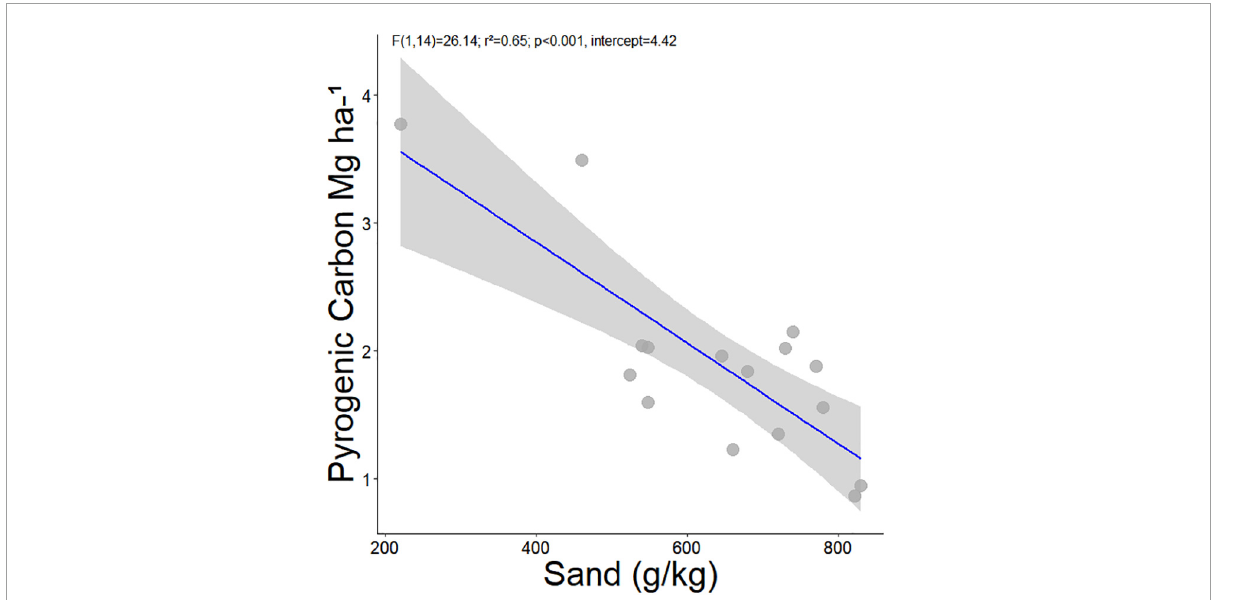
FIGURE3 Linear regression indicates the variation in soil pyrogenic carbon explained by the variation in soil sand content of 16 forest sites (excluding Amazonian Dark Earth) along the Amazon-Cerrado transition.